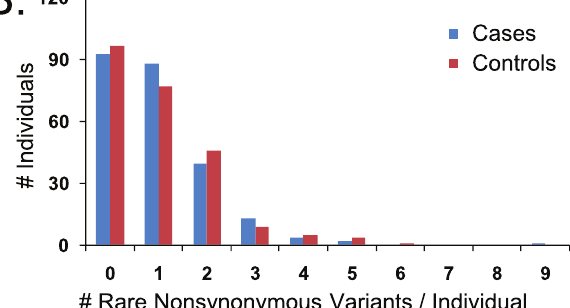
Figure 1. Total Nonsynonymous Changes in NTD Cases and Controls. A. All common nonsynonymous alleles (MAF . 2.5%) identified from the 31 folate pathway genes sequenced were summed in each individual and the case/control distributions of these sums are shown. Minor allele homozygotes were counted as two alleles whereas heterozygotes were counted as one. B. Case/control distributions of rare (MAF # 2.5%) nonsynonymous allele sums. Population means and permuted P-values are shown in Table 2.